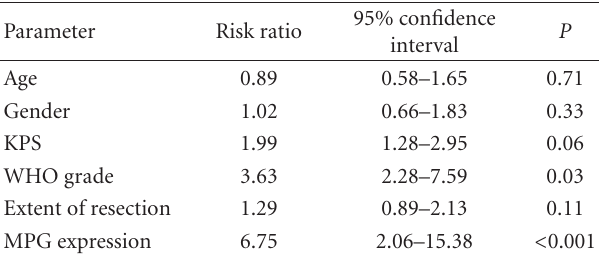
Table 2: Cox-multivariate